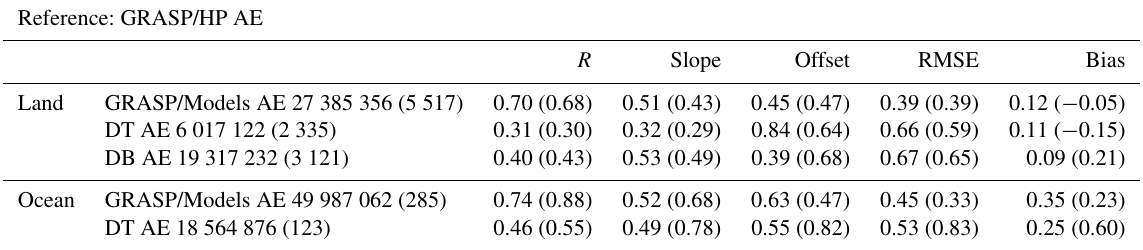
Table 18. Pixel-to-pixel statistical metrics between AE products based on references of GRASP/HP; the statistics for only AERONET pixels are presented in